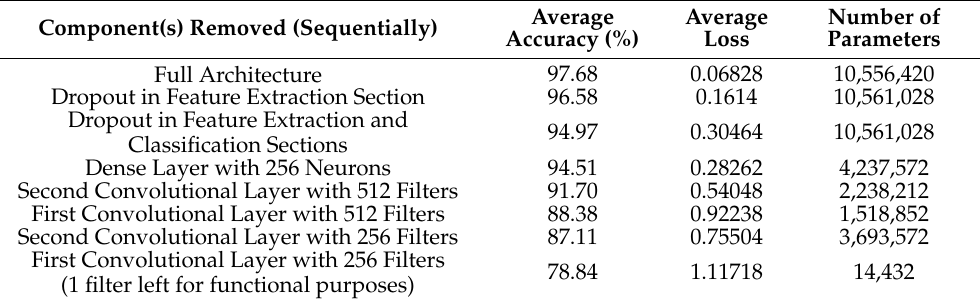
Table 4. Summary of performance metrics of Fet-Net during the ablation study.